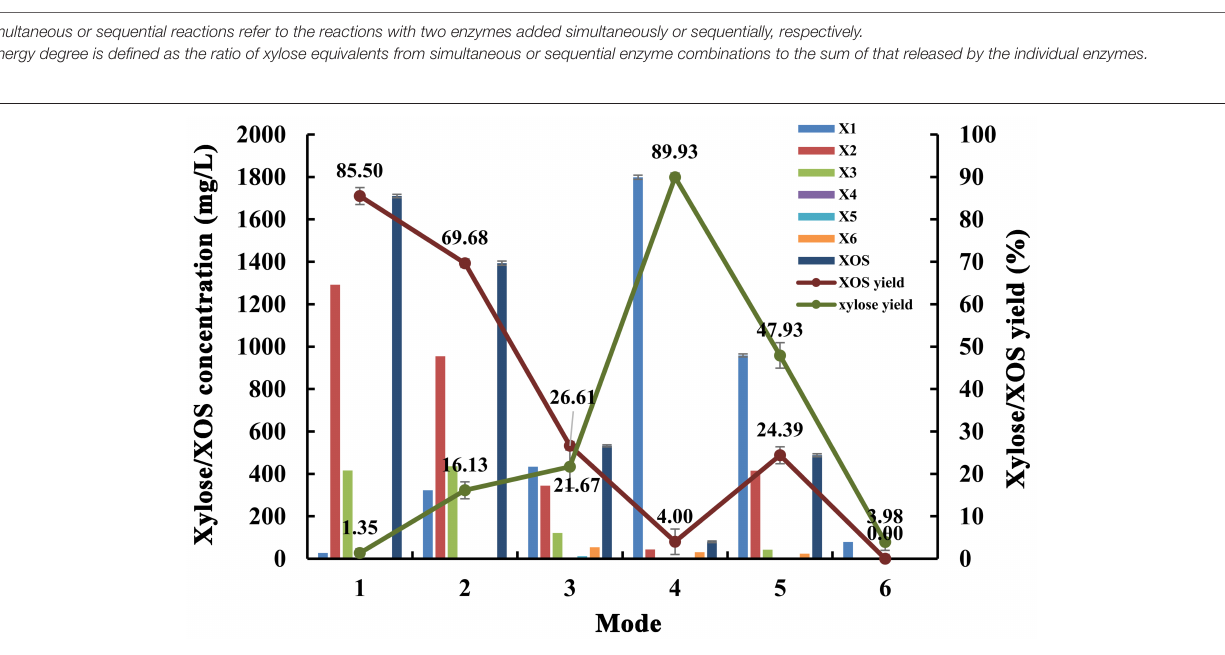
FIGURE 7 | Effects of different enzymatic hydrolysis modes on degradation products and yield of poplar sawdust xylan (Mode 1: only MxynB-8 at 50 ◦ C and pH 6.0 for 18h; Mode 2: MxynB-8 and Xln-DT were added simultaneously at 50 ◦ C and pH 6.0 for 18h; Mode 3: MxynB-8 and Xln-DT were added simultaneously at 80 ◦ C and pH 6.0 for 18h; Mode 4: first add MxynB-8 at 50 ◦ C and pH 6.0 for 18h and then Xln-DT were added at 80 ◦ C and pH 6.0 for 4h; column: xylose/XOS concentration; line: xylose/XOS yield). X1, xylose; X2, xylobiose; X3, xylotriose; X4, xylotetraose; X5, xylopentaose; X6, xylohexaose; XOS,